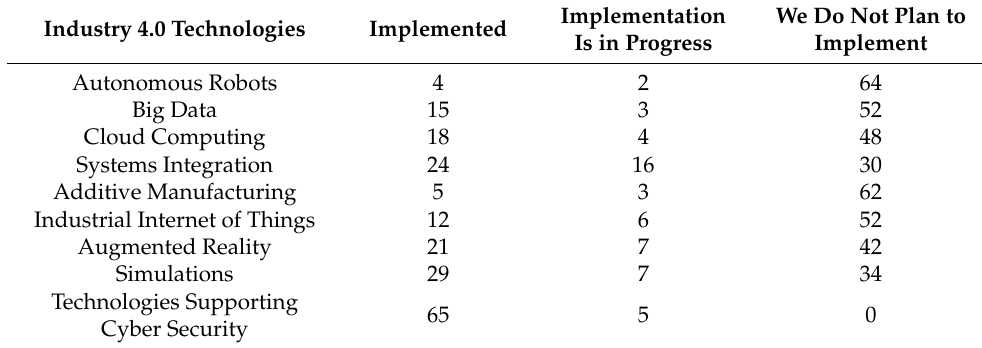
Table 1. Stages of implementing pillars of Industry 4.0 in an enterprise.